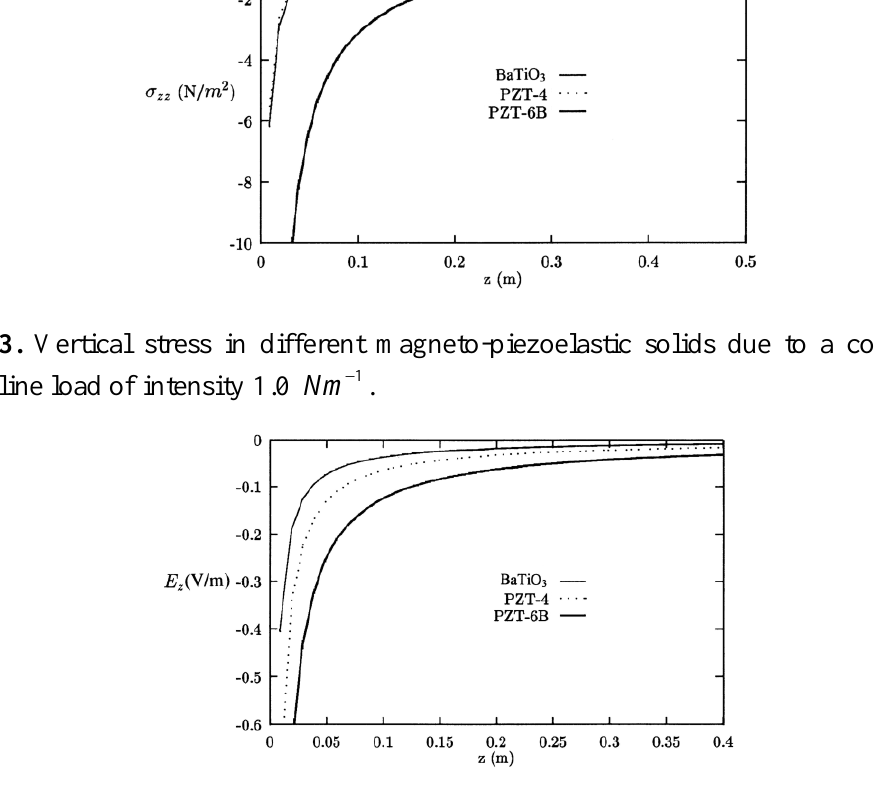
Figure 4. Electric Field in different magneto-piezoelastic solids due to a vertical line load of intensity 1.0